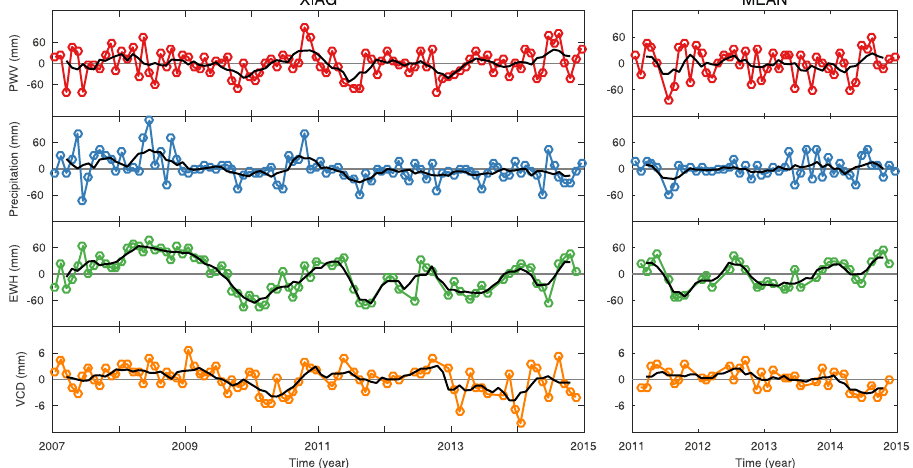
Figure 5. Monthly anomalies of PWV ( red curves ), precipitation ( blue curves ), EWH ( green curves ) and GPS- derived VCD ( orange curves ) at XIAG station and for MEAN, respectively. Their five-month moving average time series (black curves) are also shown.